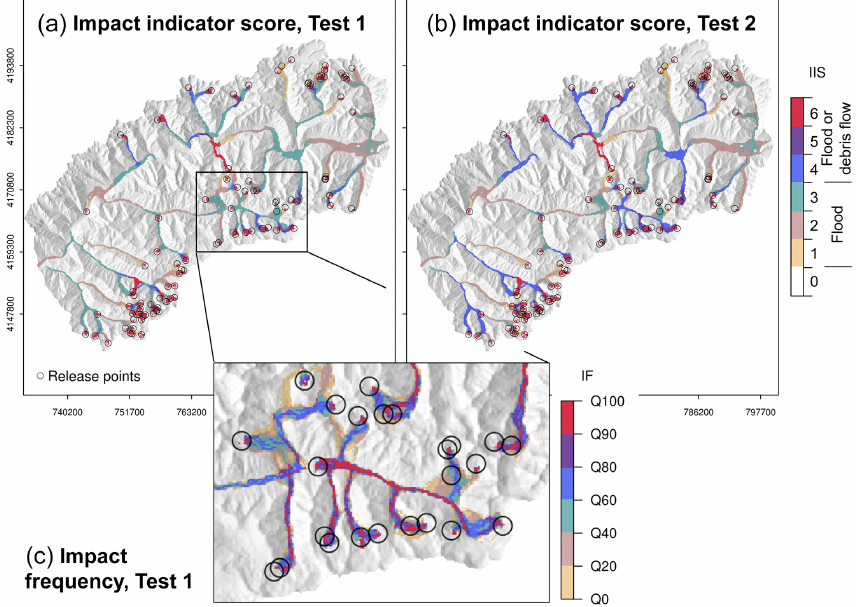
Figure 14. Possible GLOF impact areas in the Gunt Valley, Tajikistan. (a) Impact indicator score derived with test 1. (b) Impact indicator score derived with test 2. (c) Impact frequency derived with test 1, classified by